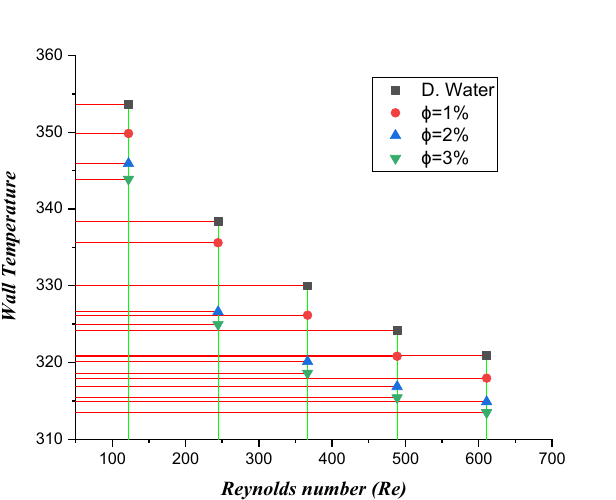
Figure 18. Estimation of the Wall temperature against the Reynolds number in a microchannel heat sink with TiO 2 /water nanofluid and distilled